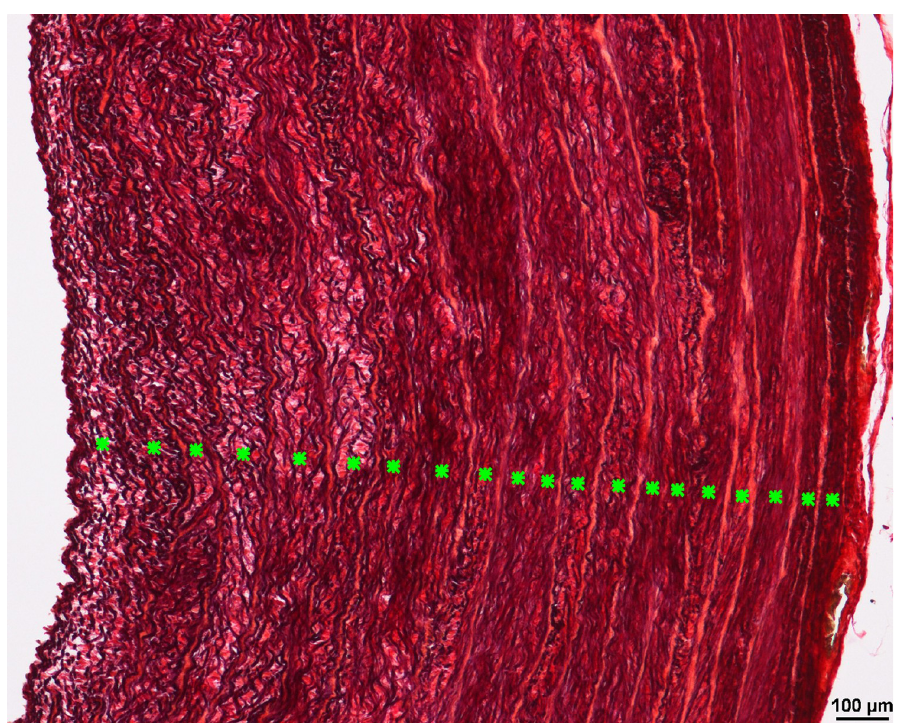
Fig 5. Internal elastic lamellae in the aortic wall of a 35-day-old Lohmann Dual chicken. Each individual elastic lamella is indicated by a green asterisk. Weigert’s Resorcin Fuchsin.